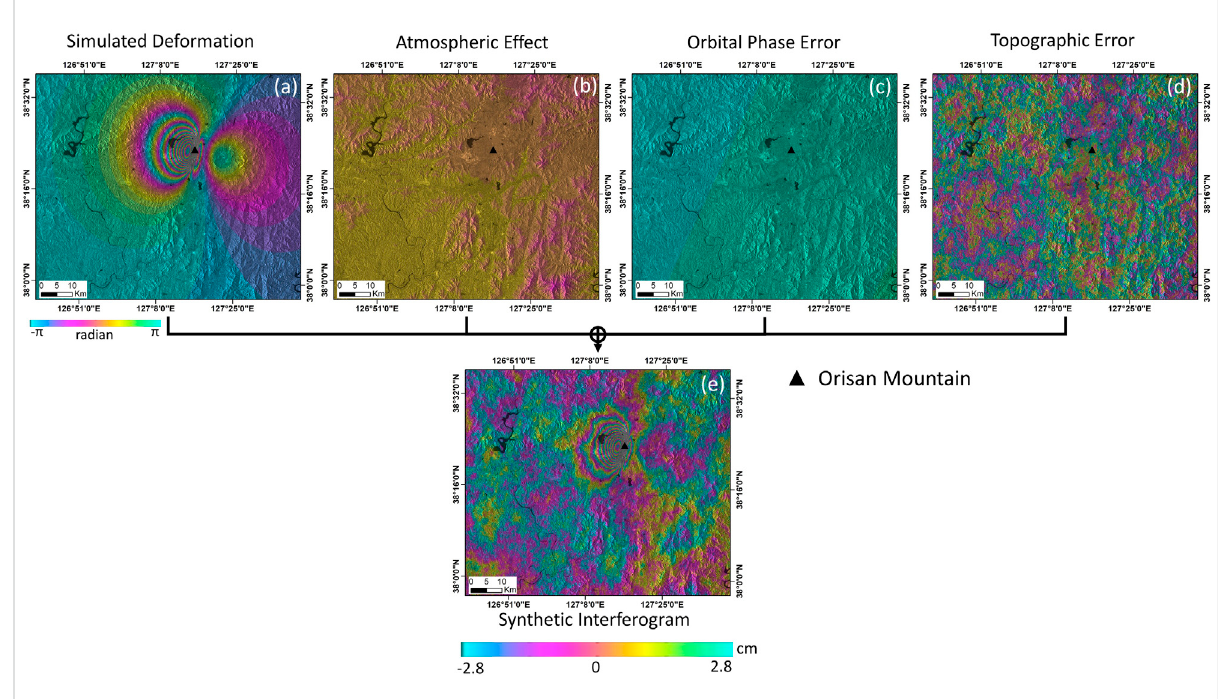
FIGURE 2 Work fl owofthesimulationinterferogramprocessusingtheOkadamodelforsimulateddeformation (A) andsimulatederrorgenerationsuchas atmospheric effect (B) , orbital phase error (C) , and topographic error (D) to generate the simulation interferogram (E) .